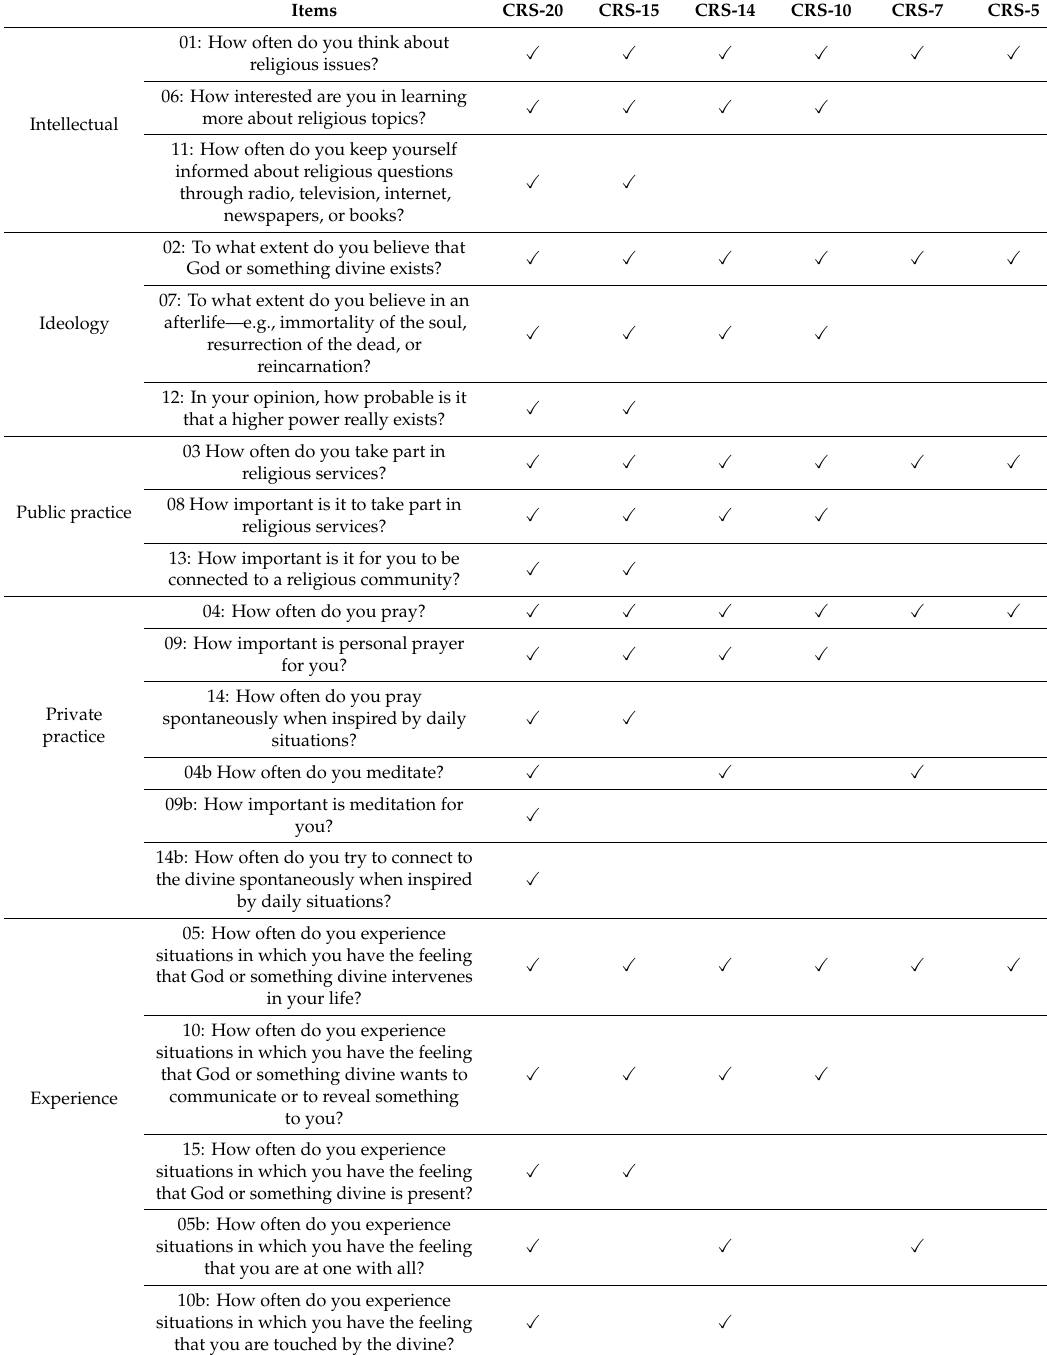
Table A8. Table for Di ff erent Versions of the CRS. Items CRS-20 CRS-15 CRS-14 CRS-10 CRS-7